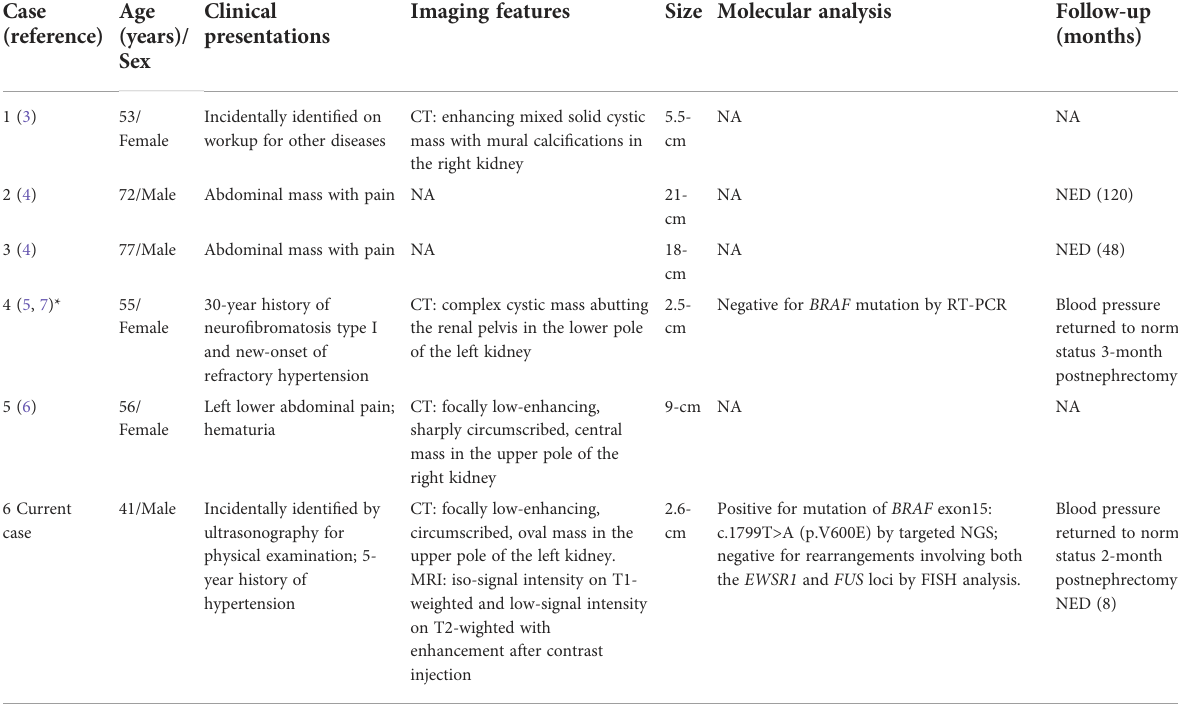
TABLE 1 Summary of adult metanephric stromal tumor reported in the literature. Case Age (reference)